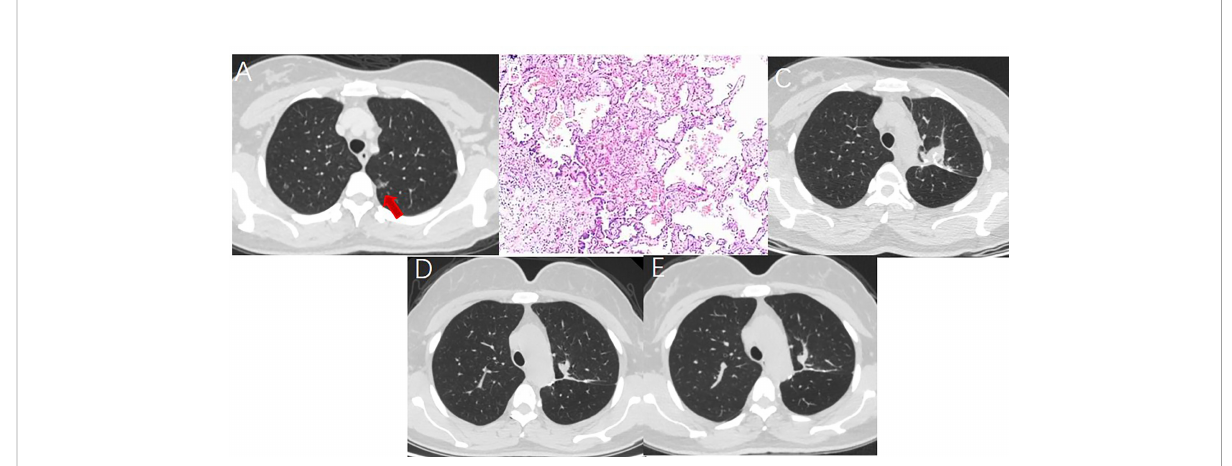
FIGURE 2 A 52 year-old woman with multiple GGNs underwent resection of apical posterior segment of left upper lobe and lymph node sampling. (A) A ground glass nodule with a diameter of 1.5cm located in the left upper lobe. (B) Postoperative pathology showed minimal invasive adenocarcinoma with no lymph node metastasis. (C) Soft tissue-density mass and linear stapler can be seen in the operation area on the CT image one month after surgery. (D) The soft tissue density mass in the operation area shrank 7 months after surgery. (E) The operation area formed fi brous scar 14 months after